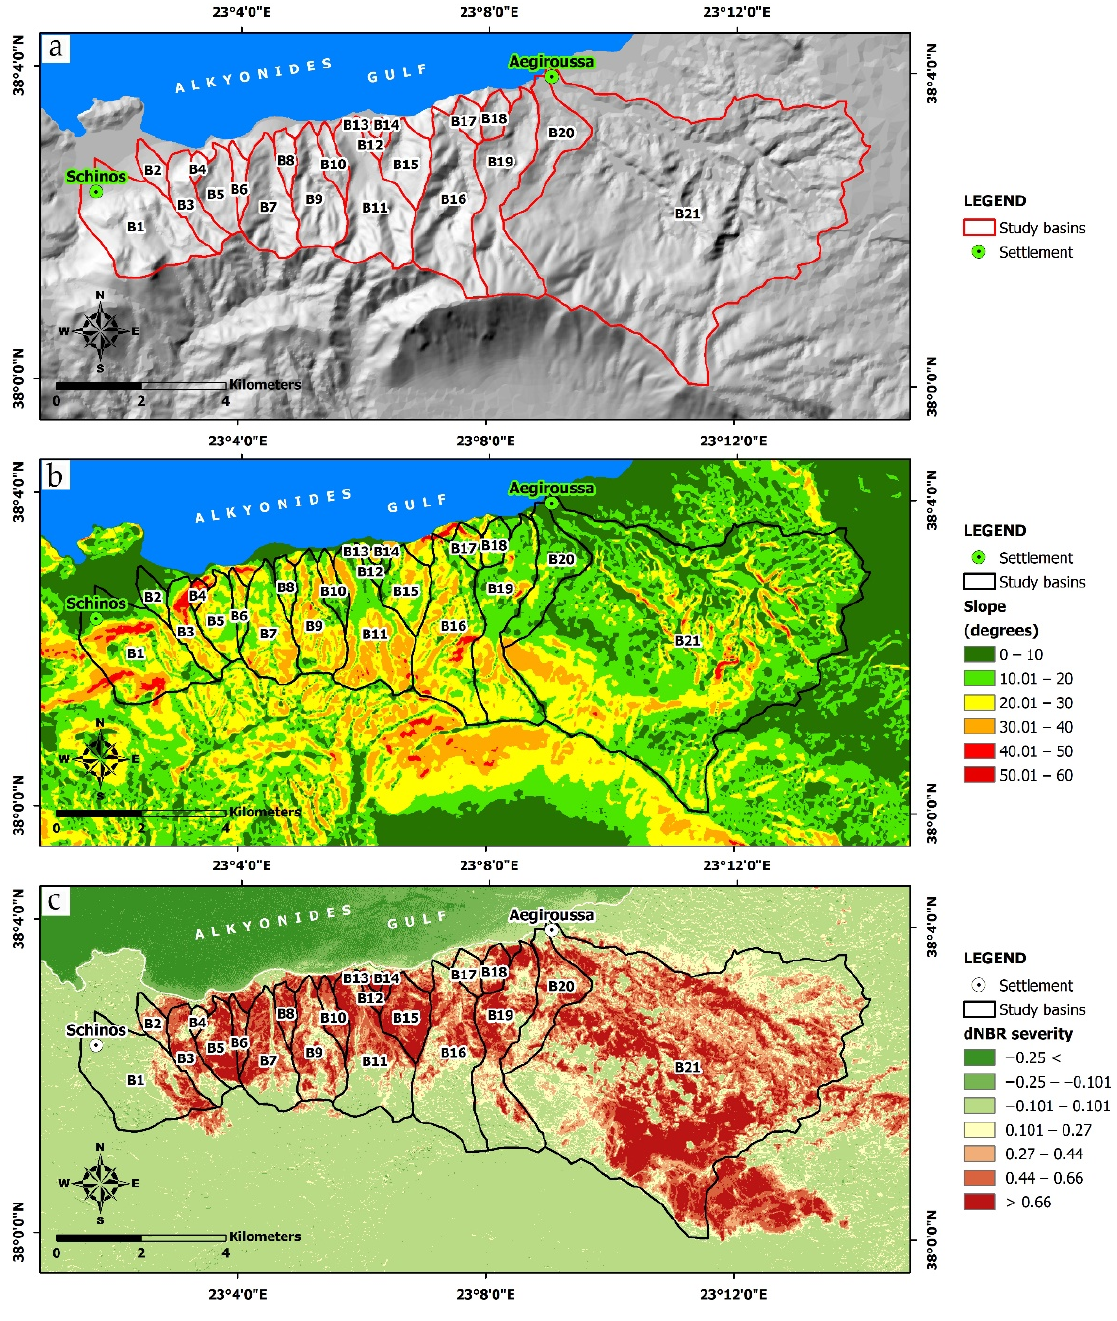
Figure 2. Maps of the study basins against ( a ) the local relief, ( b ) the slope inclination of the study area, and ( c ) the burnt area along with dNBR burn severity.